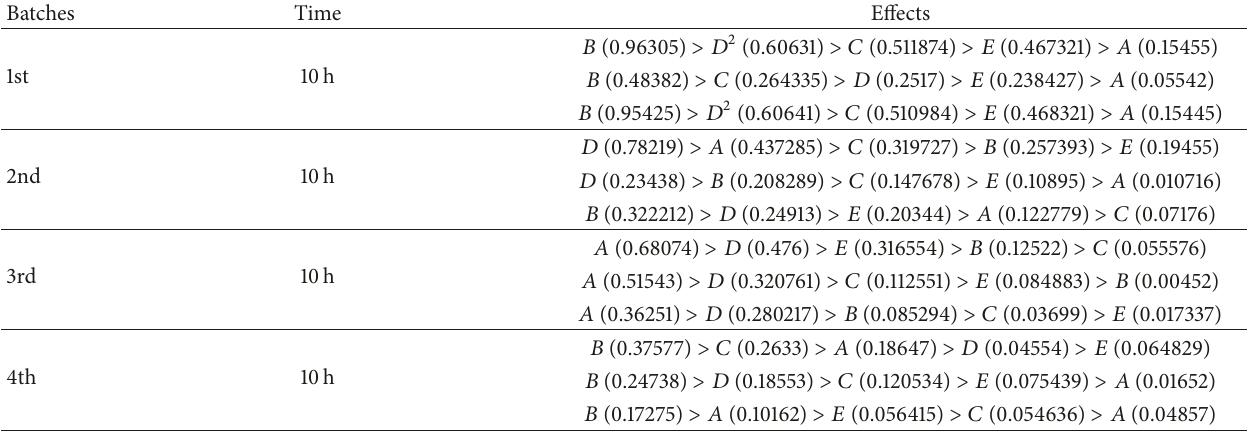
Table 10: Standard regression analysis (SRA) and effects of variables on DR